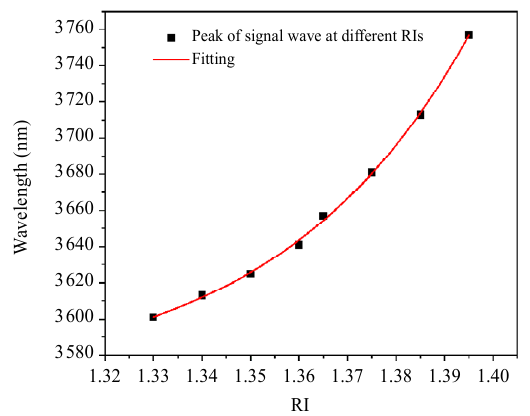
Fig. 8 Peak motion of the signal wave changes with RI at 3 420